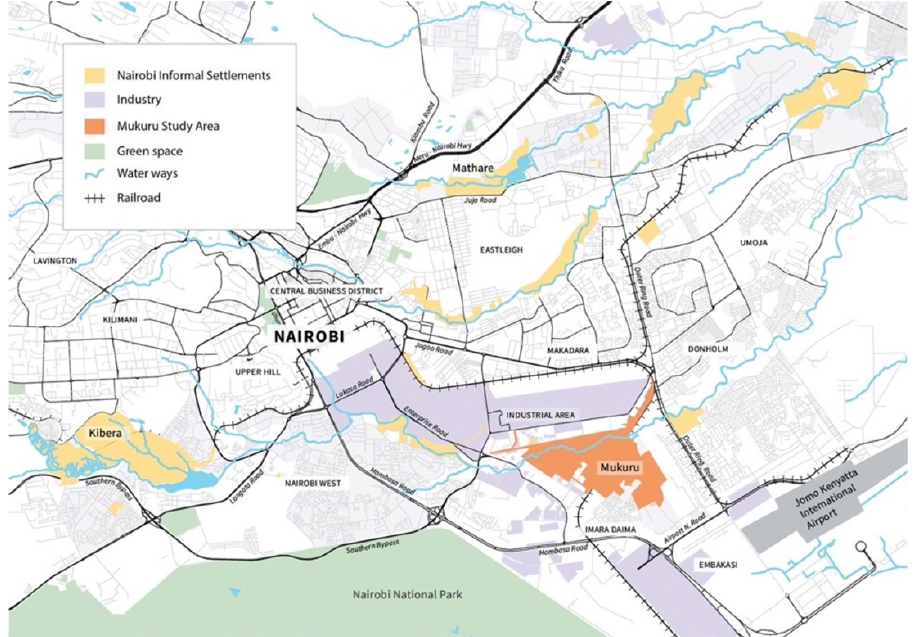
Figure 1. Map of Nairobi and the location of the Mukuru Informal Settlement.